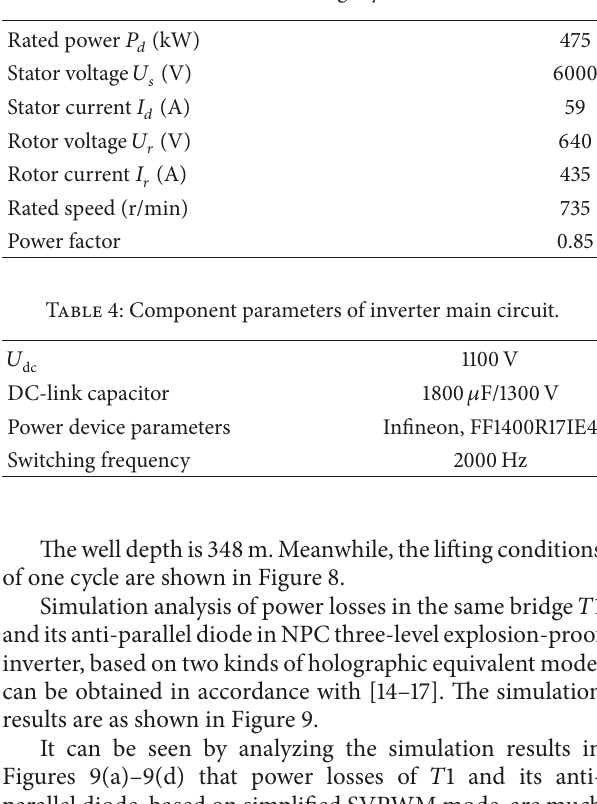
Table 3: Parameters of winding asynchronous motor.